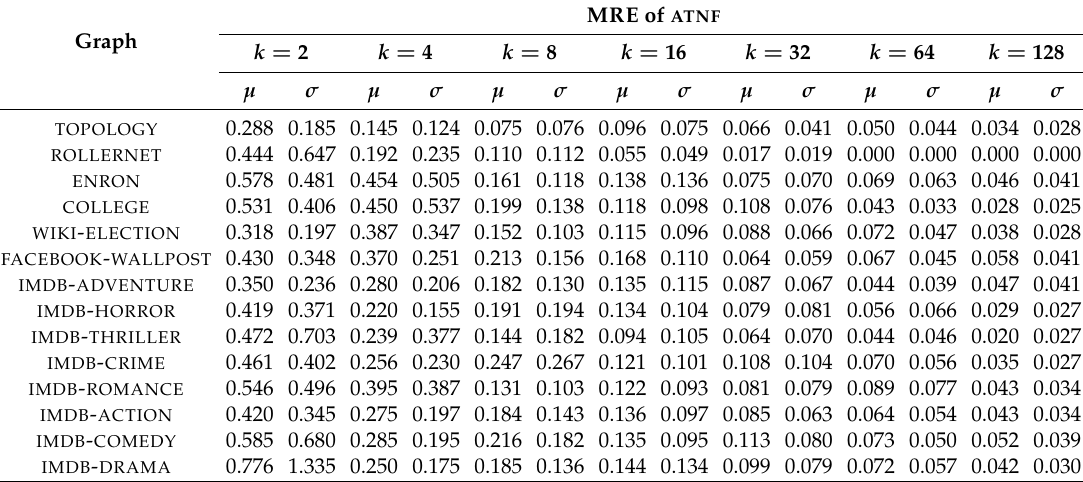
Table 3. Comparing the quality of the approximation of ATNF (our method for approximating the earliest arrival reverse temporal cones) with respect to ETNF (the exact method in [9]) for approximating |N ( I ) | . For each k , the average µ and the standard deviation σ of the MRE (Mean Relative Error) over ten experiments are reported. MRE of Graph